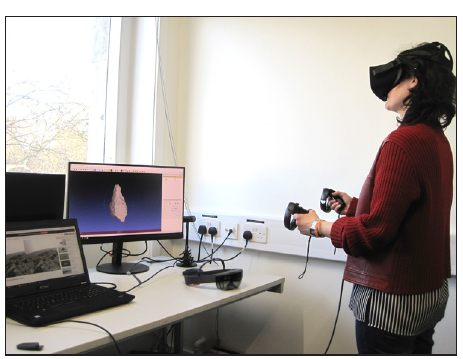
Figure 1: VR googles in use in the IoA Digital Heritage and Virtual Reality Laboratory (Photo: Carmen Martin